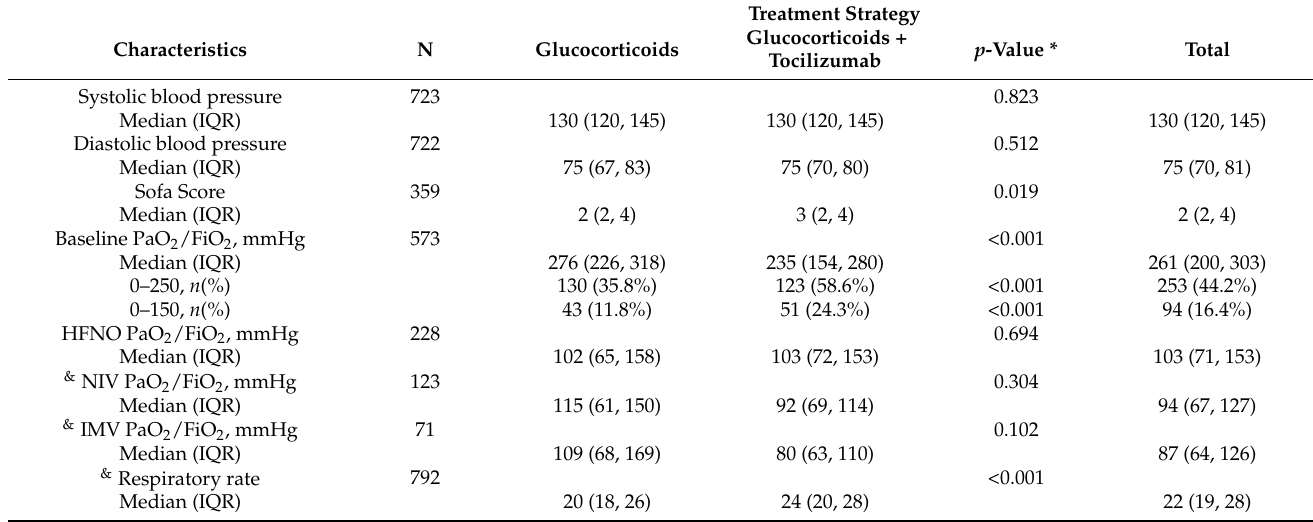
Table 2. Vital signs at admission and in follow-up by treatment group.